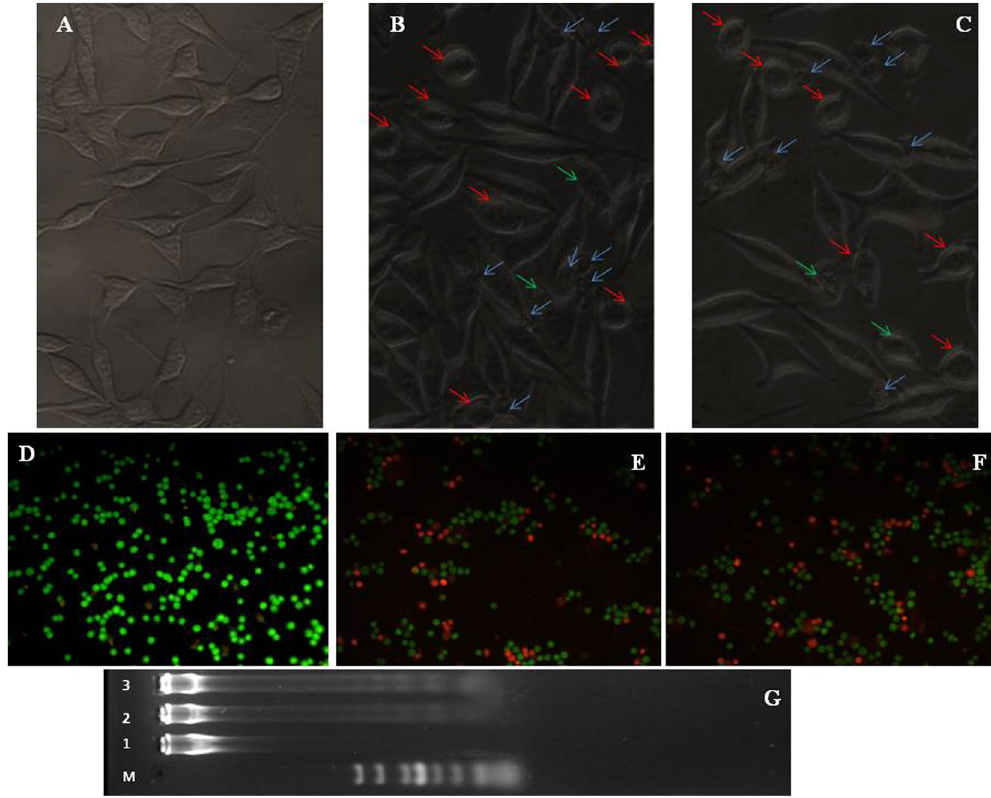
Figure 7. Upper row: Inverted microscopic images of MDA-MB-231 cells treated with LD 50 concentrations of SNPs and ASNPs for 24 h. ( A ) Untreated cells as control, ( B ) treated cells with SNPs, and ( C ) treated cells with ASNPs. Blue arrows: apoptotic bodies. Red arrows: condense cytoplasm. Green arrows: membrane integrity loss. Intermediate row: Fluorescent microscopy of MDA-MB-231 cells stained with acridine orange/ethidium bromide. ( D ) Untreated cells as control, ( E ) treated cells with SNPs, and ( F ) treated cells with ASNPs. ( G ) DNA ladder on agarose gel electrophoresis. Lane M: 1 kB ladder, lane 1: control, lane 2: SNPs (7 µ M) and lane 3: ASNPs (5 µ